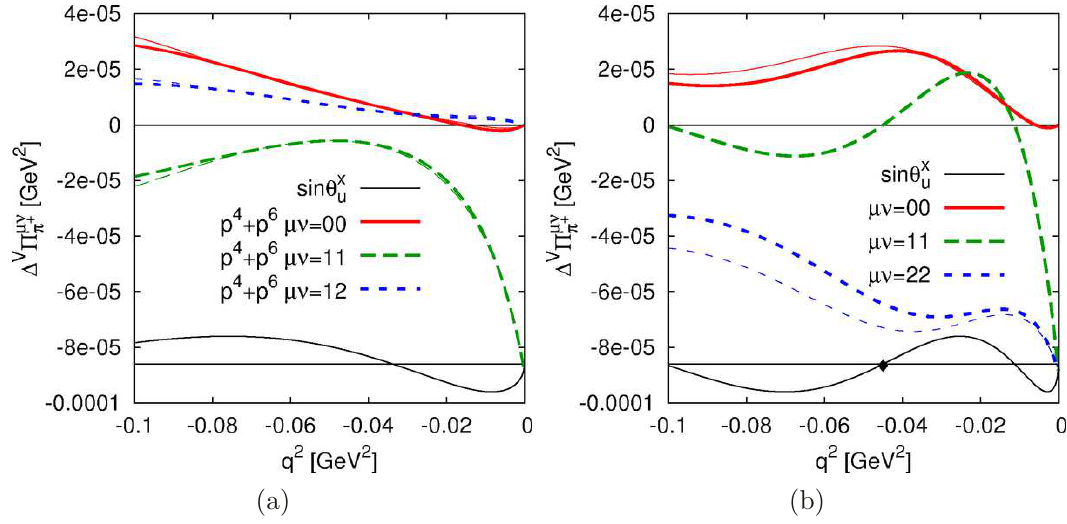
Figure 6 . The finite volume corrections adding p 4 and p 6 . The p 4 corrections are shown as the thin lines where each thin line should be associated with the same pattern and colour (and closest) thick line. The lower straight line indicates zero around which sin θ x symmetric case (b) Twisting only the x -direction. The diamond indicates a q 2 accessible with periodic boundary